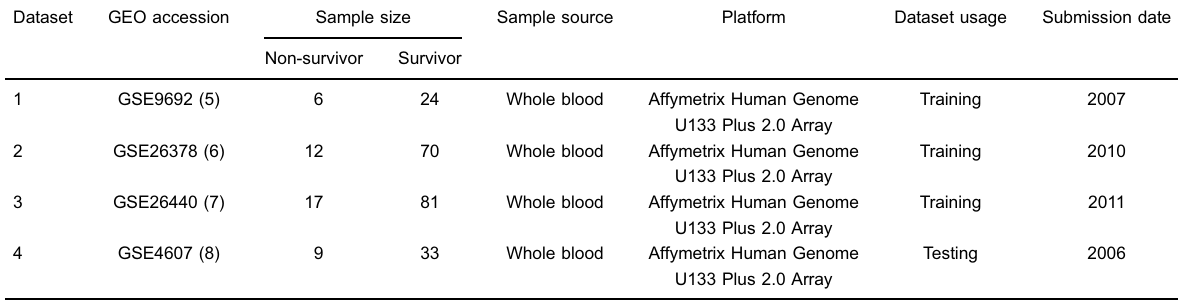
Table 1. Microarray datasets used in this analysis.